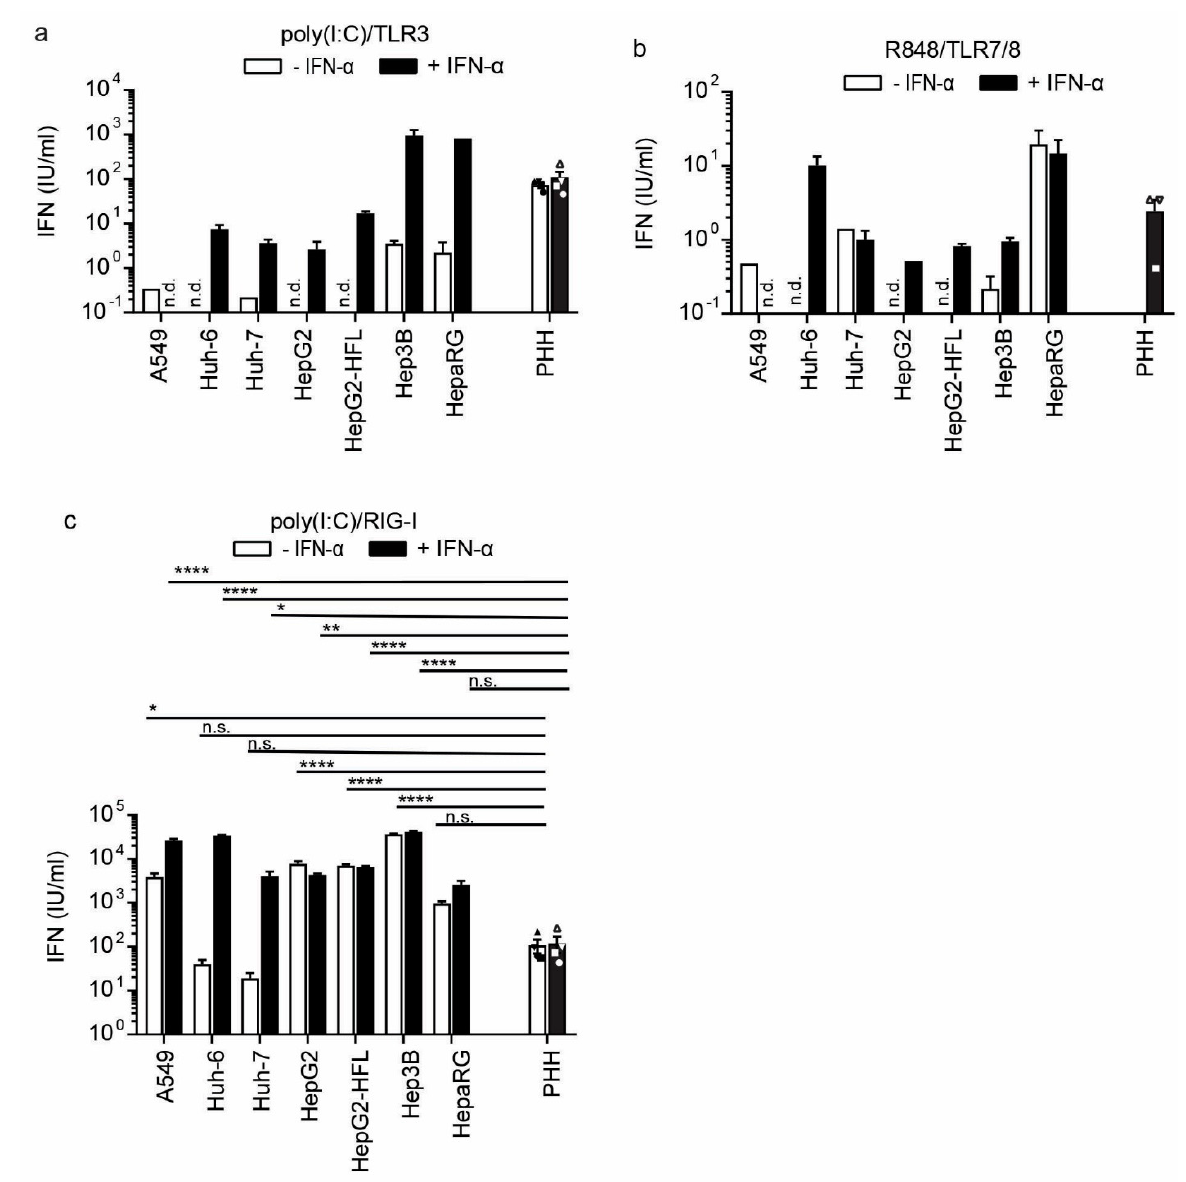
Figure 5. IFN-I secretion from PHH and hepatoma cell lines after stimulation with indicated RNA sensor agonists with and without IFN- α pre-stimulation (100 IU/mL) and further stimulated with TLR3 agonist poly(I:C) (1 µ g/mL) ( a ), TLR7/8 agonist R848 (1 µ g/mL), ( b ) or transfected poly(I:C) (2.25 µ g/well), ( c ) as RIG-I agonist. Released IFN was measured by transferring cell cultures supernatants of stimulated cells to an IFN sensitive luciferase reporter cell line. U/mL was calculated using a recombinant IFN-I standard curve. Data for the four different PHH donors are shown as mean ± SEM of a single experiment performed in technical duplicates and for the cell lines as mean ± SEM of one representative of three independent experiments (performed in technical triplicates). Two-way ANOVA, followed by Dunnett’s multiple comparison test * p < 0.05, ** p < 0.01, **** p < 0.0001. n.d. = not detected.